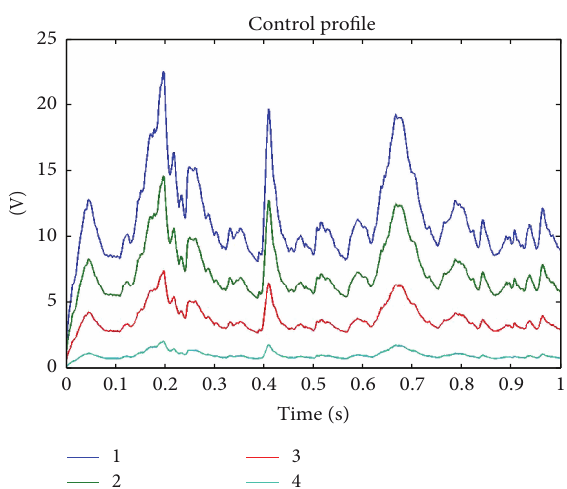
Figure 6: Control produced voltage at all beam nodal points with LQR control.